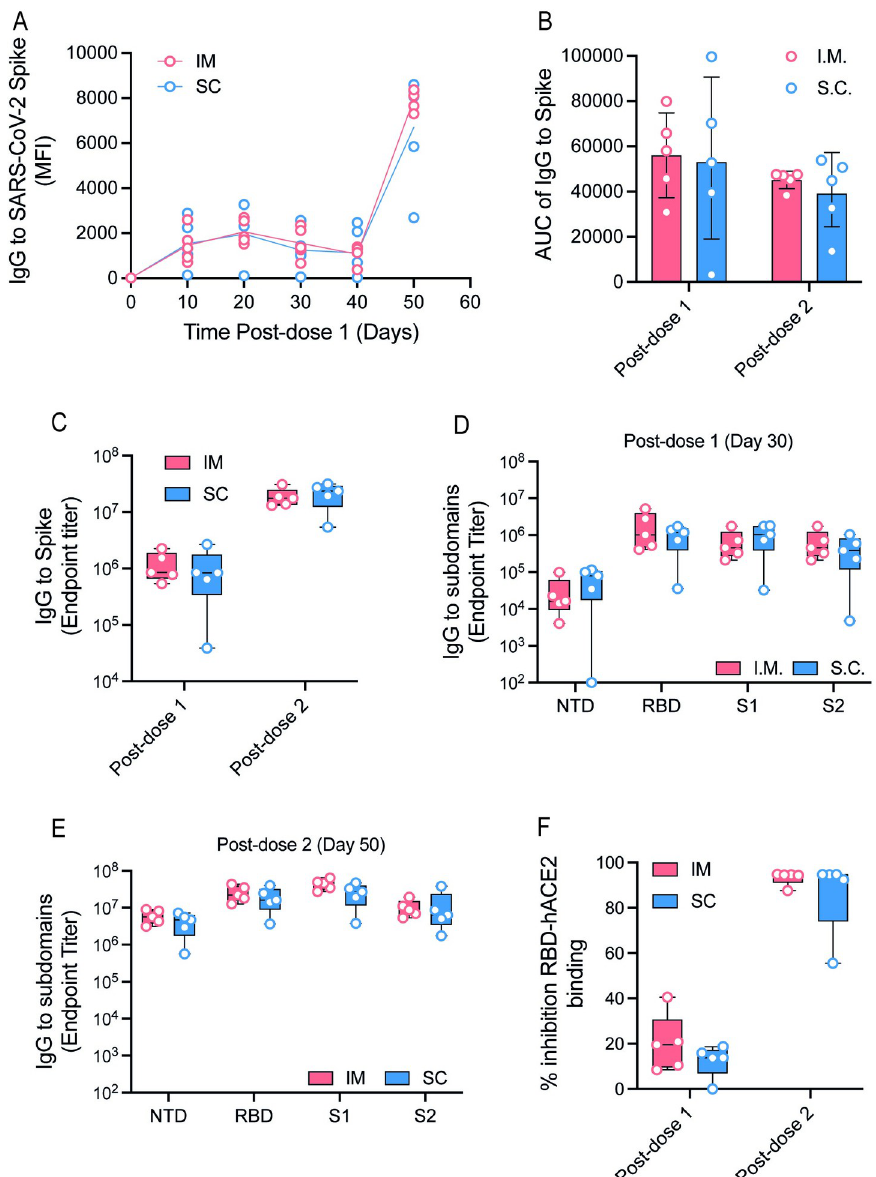
Fig 7. Vaccination induced antibody response was comparable in animals vaccinated via the s.c. as compared to i. m. routes. (A, B) IgG against the SARS-CoV-2 Spike protein over time (A) and total AUC (B), assessed with a whole spike protein in a Luminex immune-assay (readout as MFI). (C ) IgG endpoint titers to SARS-CoV-2 whole spike 30 days postdose 1 and 10 days postdose 2. (D, E) IgG endpoint titer to SARS-CoV-2 NTD, S1, S2, and RBD proteins at 30 days postdose 1 (D) and 10 days postdose 2 (E). (F ) Inhibition of RBD binding to hACE2 receptor 30 days postdose 1 and 10 days postdose 2 of vaccination represented as a percentage. Data presented as means ± SD. In vivo experiments were conducted with a minimum of n = 5 per group. Unpaired Student t test was used for experiments comparing 2 groups. � P < 0.05. Data underlying this figure can be found in S1 Data. AUC, area under the curve; i.m., intramuscular; MFI, mean fluorescence intensity; NTD, N-terminal domain; RBD, receptor binding domain; SARS- CoV-2, Severe Acute Respiratory Syndrome Coronavirus 2; s.c., subcutaneous.